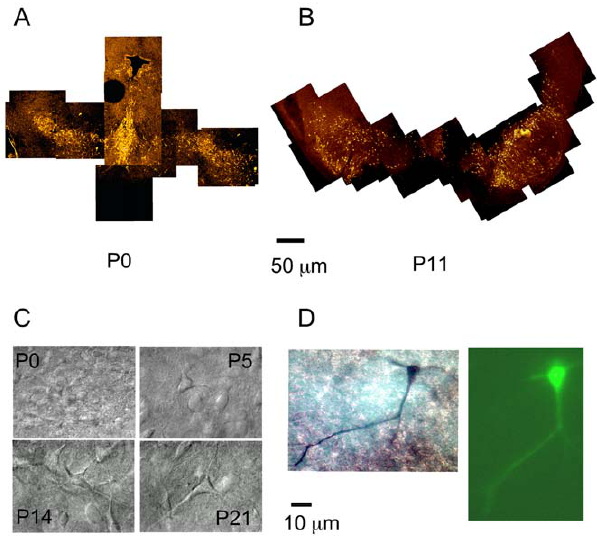
Figure 1. Distribution, morphology, and double staining of SN DA neurons. (A) TH staining of rat midbrain neurons in transversal sections of 200 m m thickness. Sections were cut, fixed, and labeled with a fluorescent anti-TH antibody as described in the methods. TH- antibody staining of a P0 rat. Migrating cells from the forth ventricle can still be observed. Bar is 50 m m. (B) TH-antibody staining of a P11 rat. The left-hand side SN at P11 is more rostral and shows a wide spread localization of DA neurons. The right-hand side SN at P11 is more caudal, and shows already the typical SN compacta band in the dorsal aspect, and less number of displaced dopamine neurons outside the compacta area. Dorsal is up and ventral down. (C) Infrared IR-DIC optics images of SN neurons. Rat slices prepared according to the methods section. Infrared pictures of neurons in the SN as observed during the electrophysiological recording. (D) Double stained SN DA neuron at P3. The image on the left shows the TH staining. The image on the right shows the LFY filled neuron.